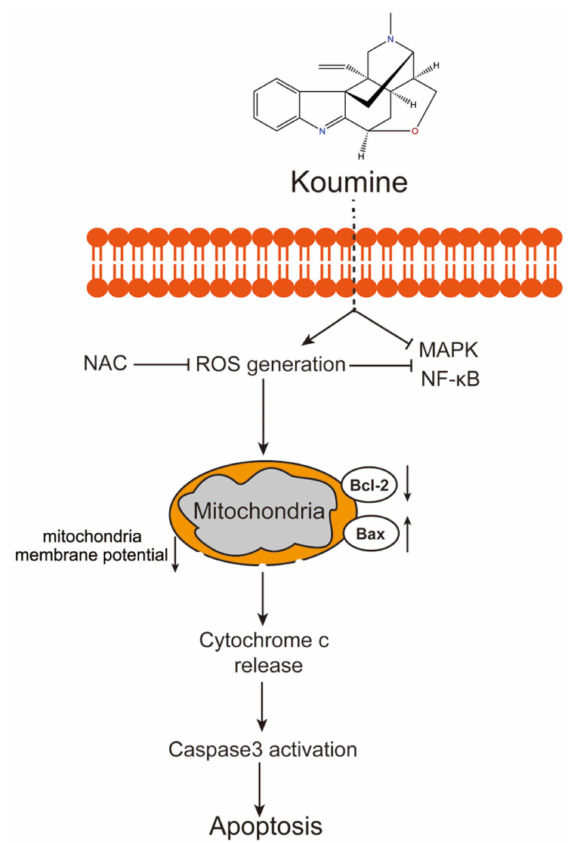
Figure 6. A schematic diagram of the proposed mechanisms of koumine induced apoptosis in HCC cells. The → indicates release, activation or